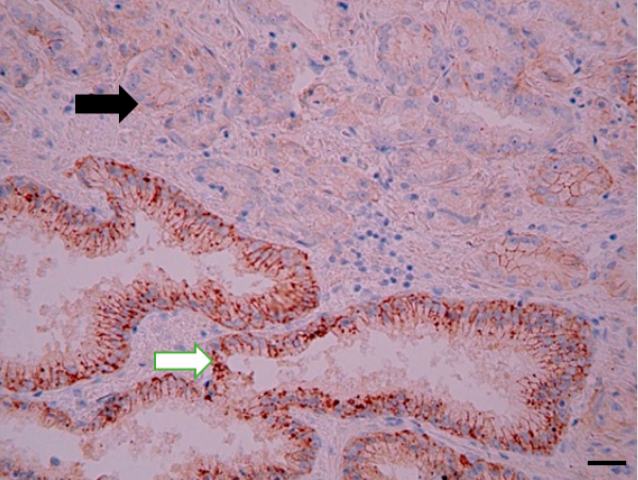
Figure 5. Loss of CD9 expression in prostate acinar adenocarcinoma. The black arrow indicates loss of CD9 protein expression in acinar adenocarcinoma, and the white arrow shows preserved CD9 expression in benign prostate glands. Immunohistochemical staining method; magnification ×400; scale bar 100 µm. tissue.